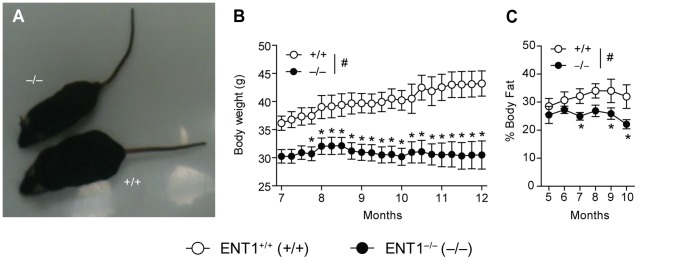
Reduced body weight in aged ENT1 null mice.
A ENT1 null mice have a smaller body size compared to wild-type littermates at 9 months of age. B When body weight was measured weekly, it became apparent that ENT1 null mice (n = 16) had significantly reduced body weigh compared to wild-type littermates (n = 15) from 7 months 3 weeks of age. C ENT1 null mice (n = 4–6) have reduced percent body fat compared to wild-type mice (n = 4–6). #
P<0.05 for significant main effect of genotype by two-way repeated measures ANOVA. *P<0.05 by two-way repeated measures ANOVA followed by Tukey post hoc test for individual comparisons. All data presented as mean ± SEM.